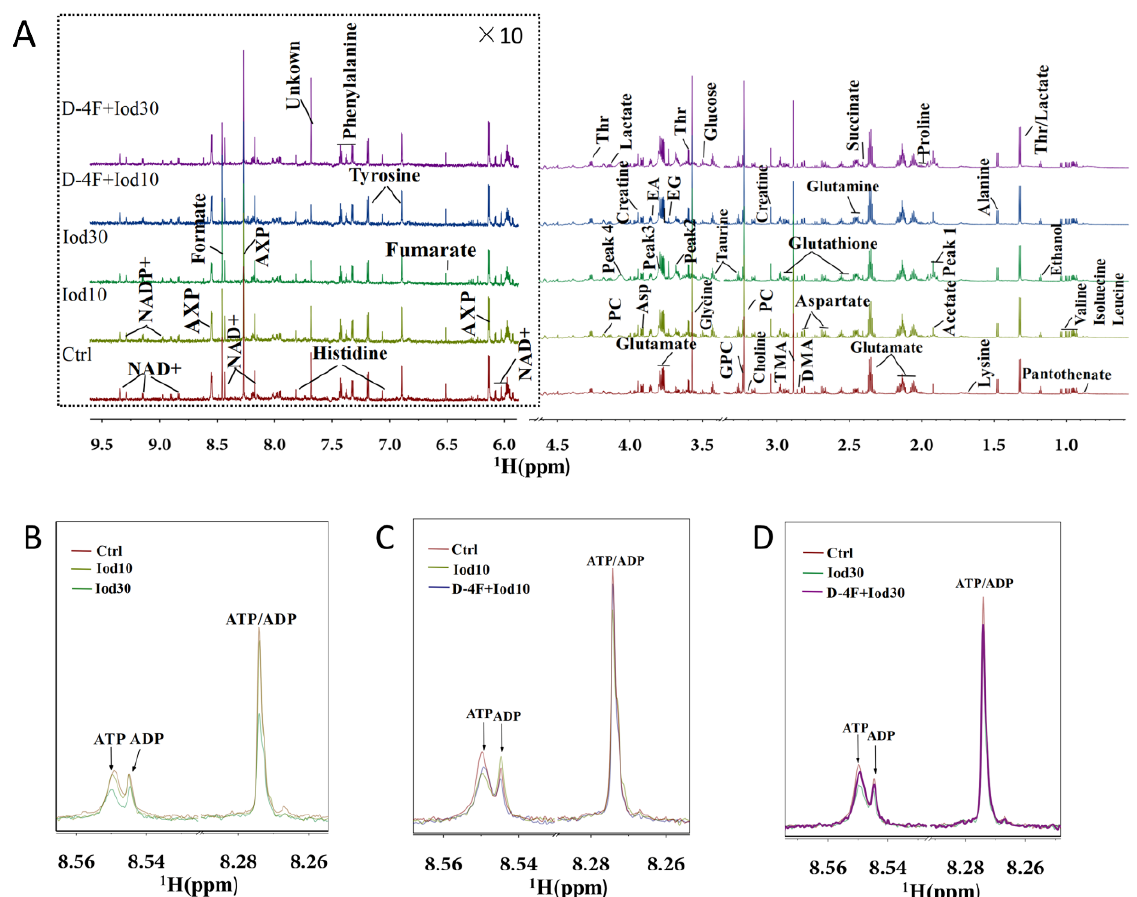
Figure 2. Average 850 MHz 1 H-NMR spectra recorded on aqueous extracts of HUVECs. Full 1 H spectra of the control group (Ctrl), Iod10-treated group (Iod10), Iod30-treated group (Iod30), D-4F with Iod10-treated group (D-4F + Iod10), and D-4F with Iod30-treated group (D-4F + Iod30) are shown ( A ). The vertical scales were kept constant in all spectra. The water region (4.8–5.5 ppm) was removed. The region of 6.0–9.5 ppm (in the dashed box) was magnified 10 times compared to the corresponding region of 1.0–4.5 ppm for the purpose of clarity. Local amplified regions of AXP peaks (overlaid ATP/ADP) for the Ctrl, Iod10 and Iod30 groups ( B ), the Ctrl, Iod10 and D-4F + Iod10 groups ( C ), and the Ctrl, Iod30 and D-4F + Iod30 groups ( D ).